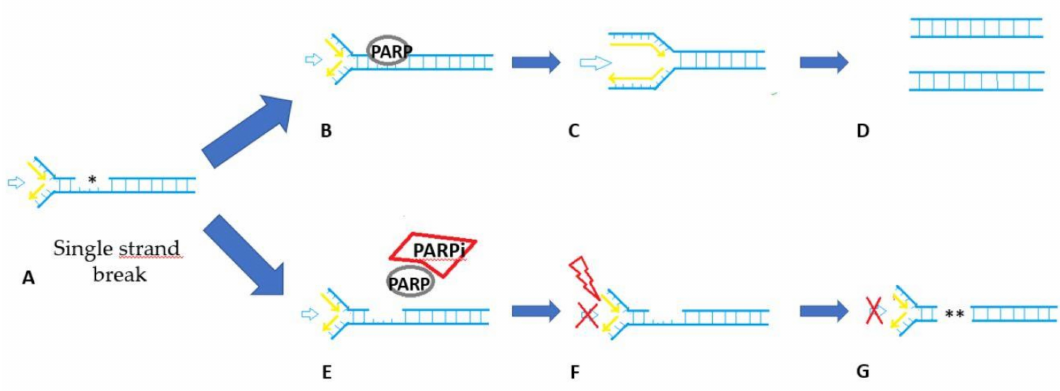
Figure 1. PARP inhibitor mechanisms. ( A ) DNA single strand break damage (SSB) appears and induce stress on the replication fork duplicating DNA in S phase. ( B ) Physiologically, the base excision repair (BER) pathway intervene through PARP enzyme. ( C ) SSB is fixe and replication proceed. ( D ) At the end of phase S the cell has 2 copies of DNA and mitosis continues. ( E ) However in the presence of PARP inhibitor (PARPi) the BER mechanism does not detect SSB and the PARP enzymes bind on the SSB are trapped. ( F ) The replication fork collapses in response to unrepaired SSB and PARP entrapment. ( G ) PARP trapping leads to double strand-break (DSB). In case of homologous repair-deficiency